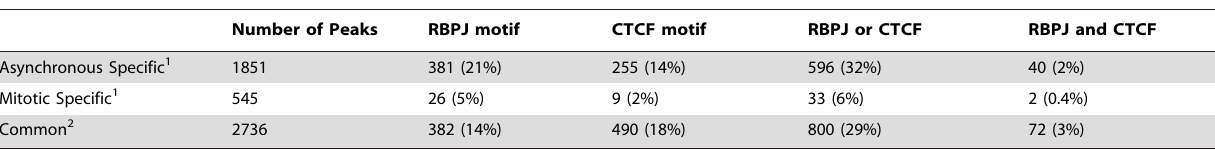
Table 1. Summary of anti-RBPJ ChIP-seq